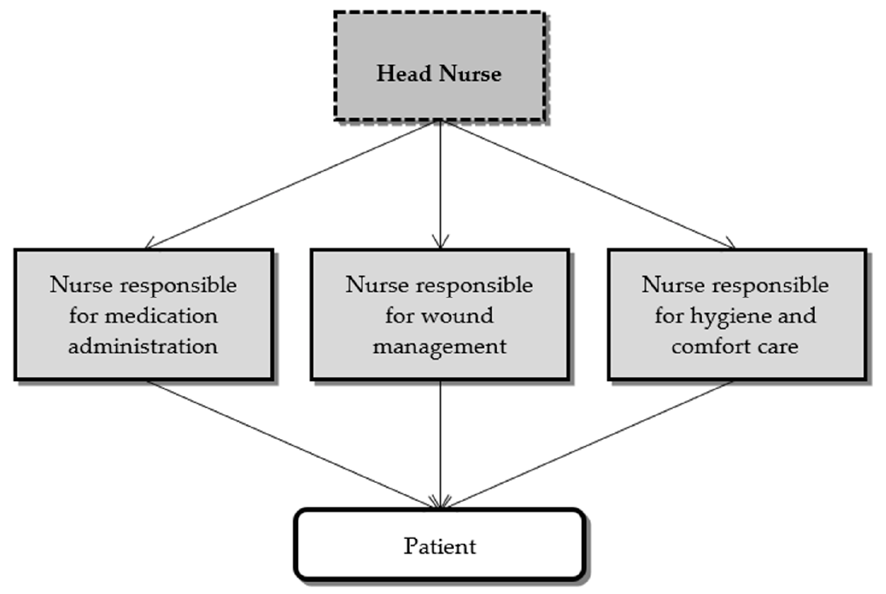
Figure 3. Structure of the functional nursing method.